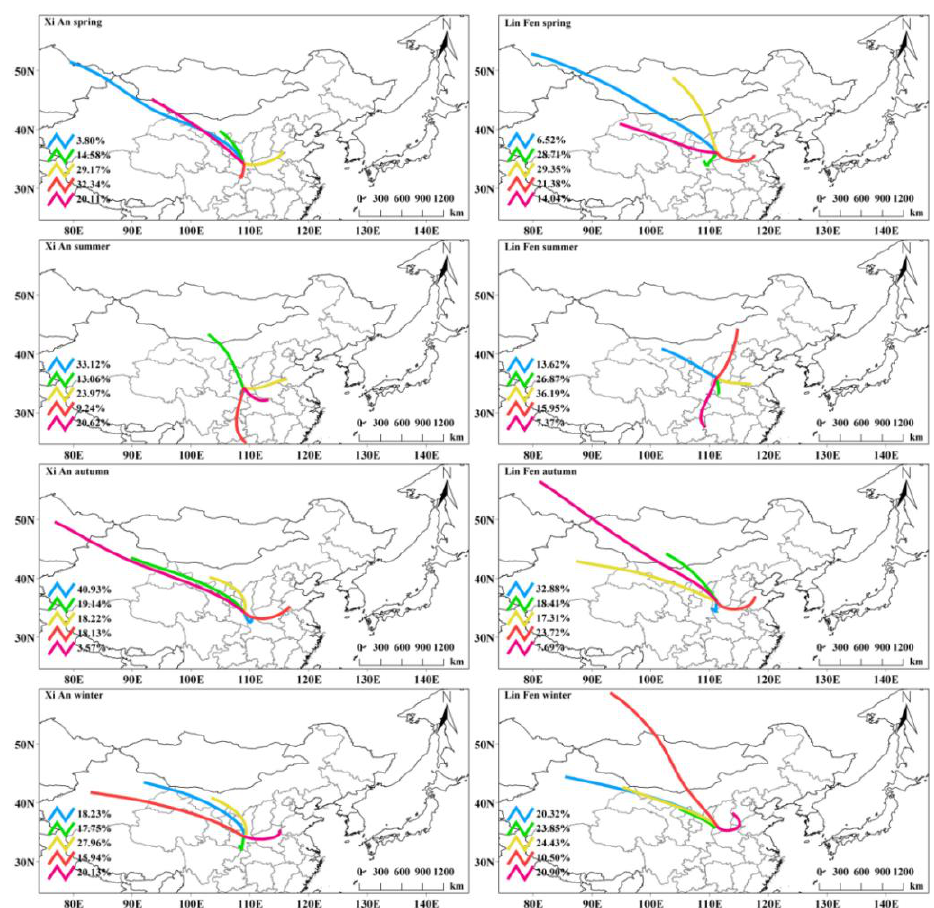
Figure 7. Air mass transport path in the four seasons of 2017 – 2019 in the Fenwei Plain.